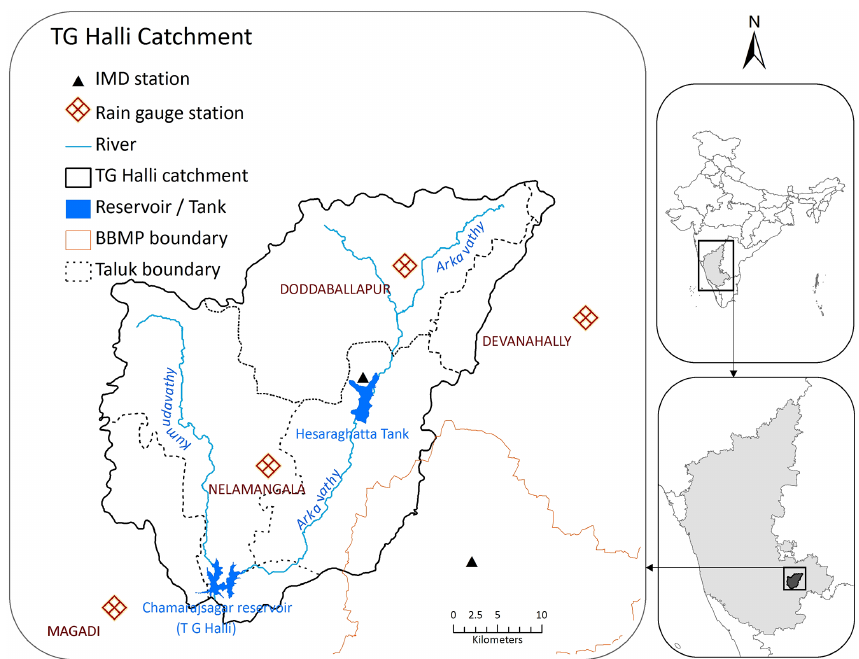
Figure 1. The TG Halli catchment with major features. BBMP is the Greater Bangalore Municipal Corporation Boundary (data source: Survey of India toposheets at 1:50000 scale; ASTER DEM imagery, maps prepared at the ATREE EcoInformatics